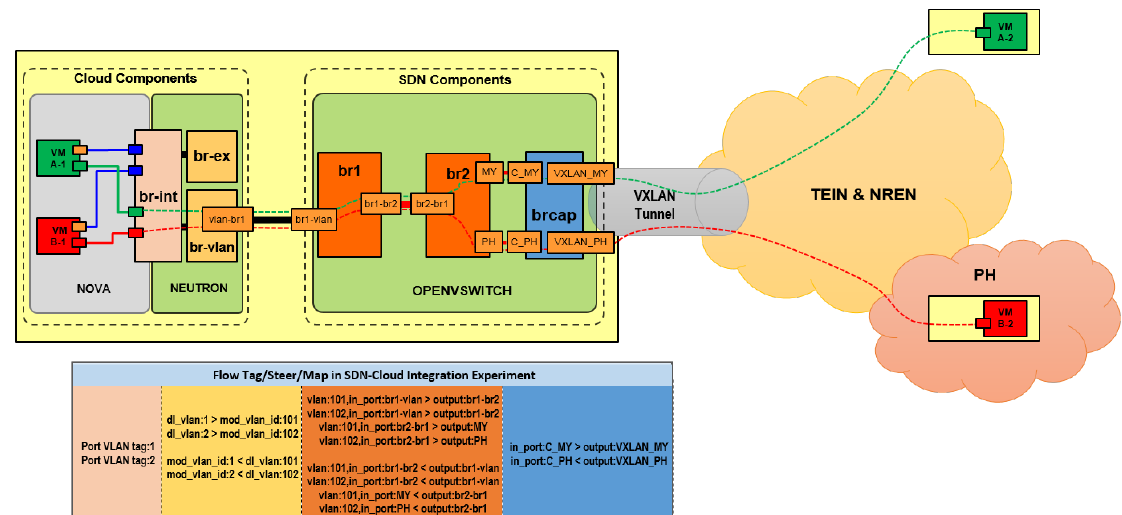
Figure 9. SDN and Cloud Control (Tag, Steer and Map) inside the SmartX